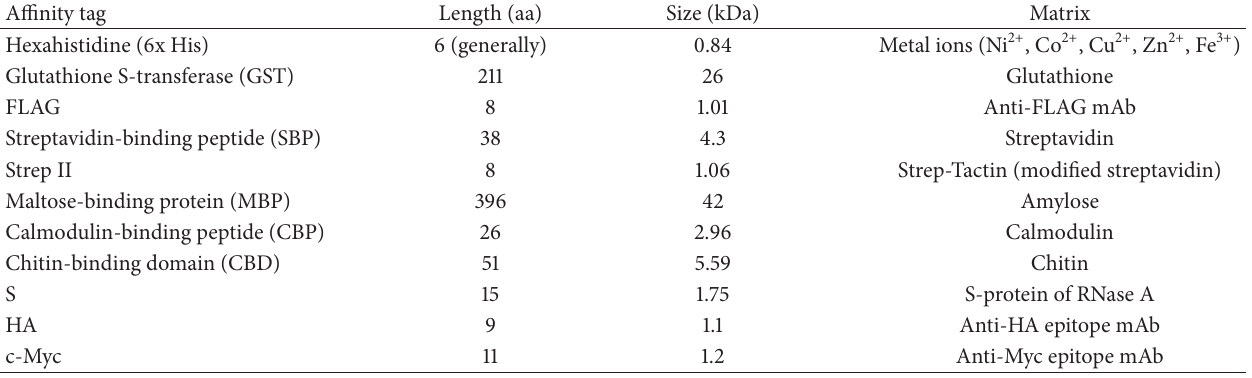
Table 1: Common widely used affinity tags for purification of recombinant proteins.